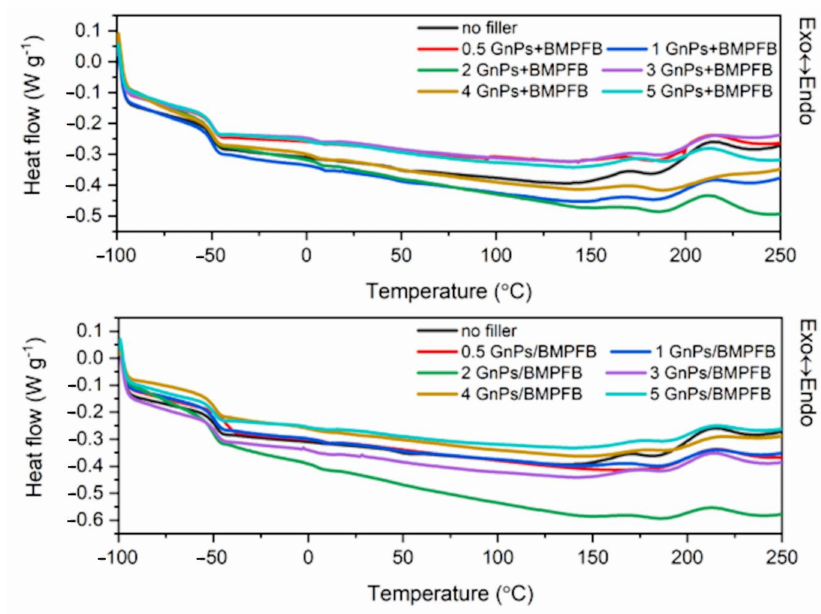
Figure 6. Heat flow response of elastomers filled with GnPs modified with BMPFB in bulk or from solution.